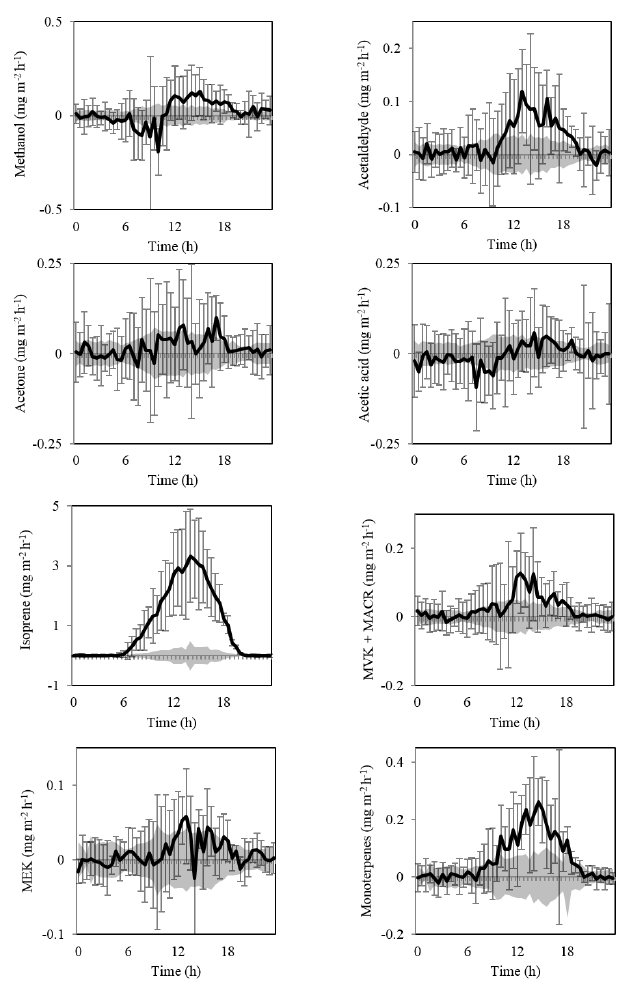
Figure 5. Mean diurnal fluxes of volatile organic compounds mea- sured using vDEC. Shaded area represents the limit of detection of the averaged data, and error bars represent one standard deviation between days from the